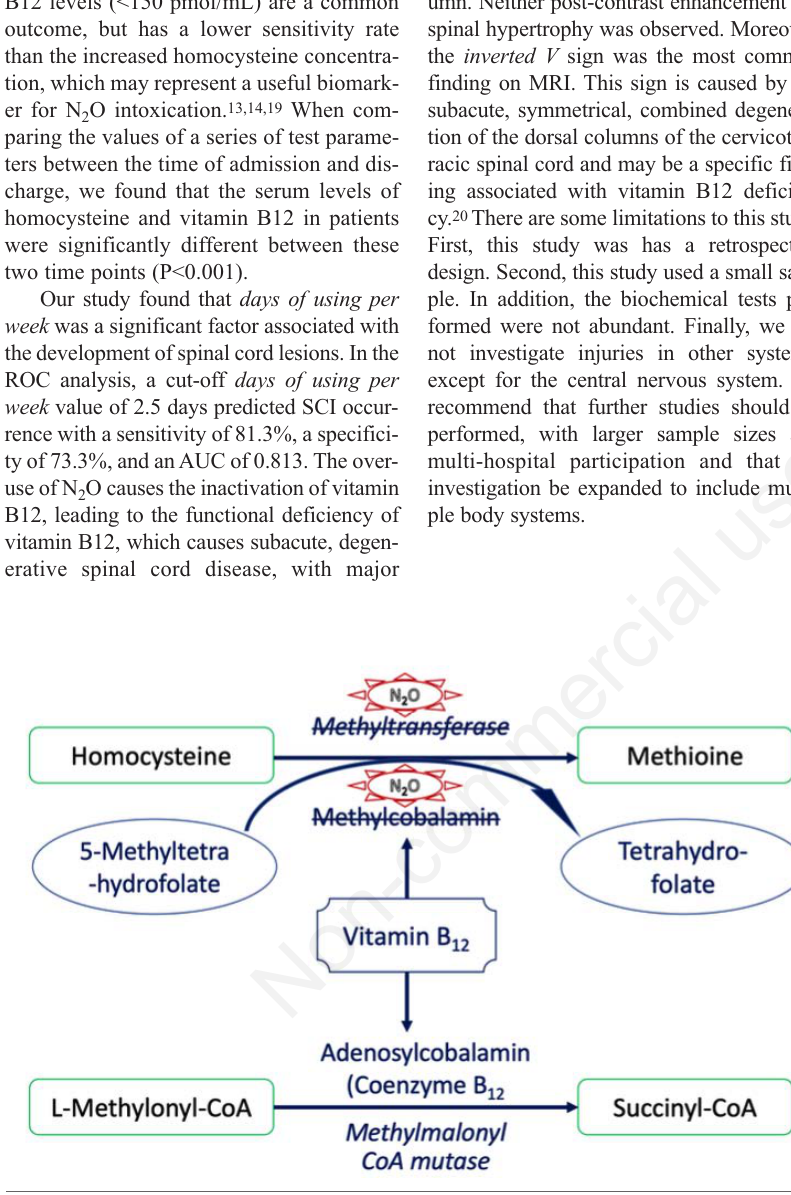
Figure 3. Pathogenesis mechanism of N 2 O